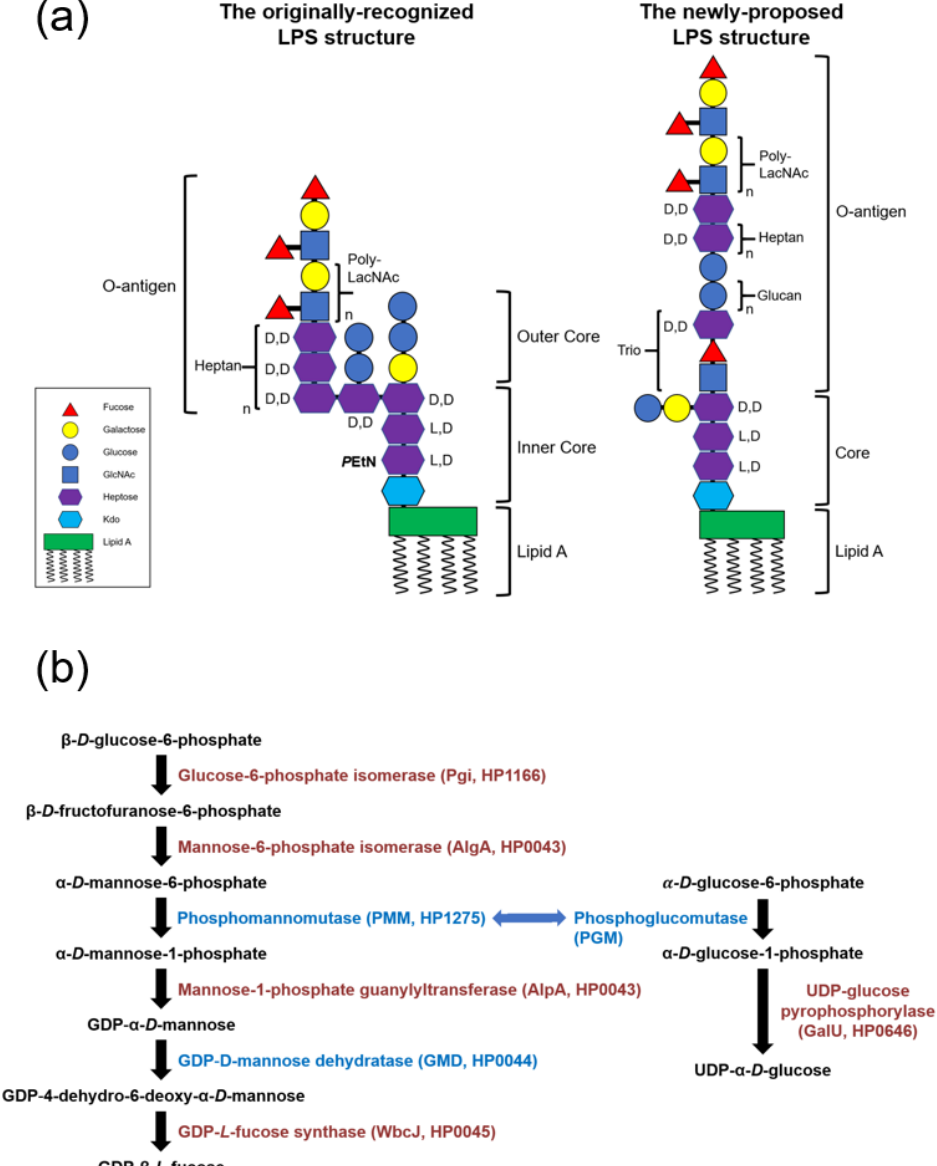
Figure 1. Diagrams of the LPS structure and fucose biosynthetic pathway in H. pylori. ( a ) The originally well-recognized LPS structure of H. pylori wild-type strain 26695 and the re-defined LPS structure in H. pylori wild-type strains G27 and 26695. ( b ) The putative fucose biosynthetic pathway in H. pylori wild-type strain 26695 (the enzymes tested in this study are marked in